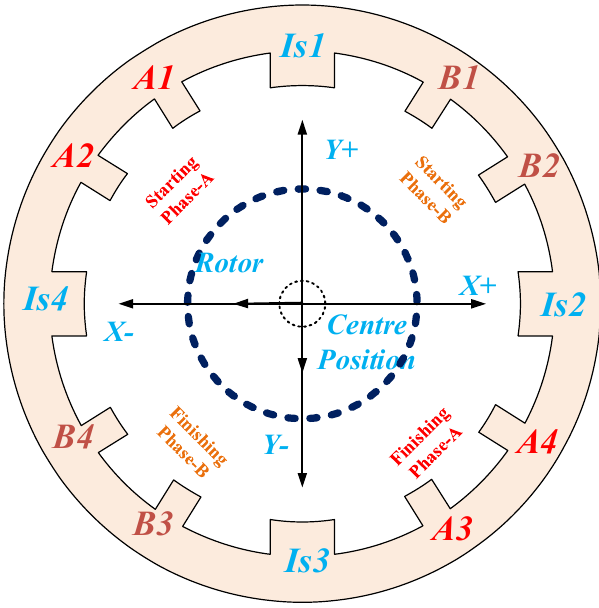
Figure 1. The 12/14 BSRM structure and winding pattern.